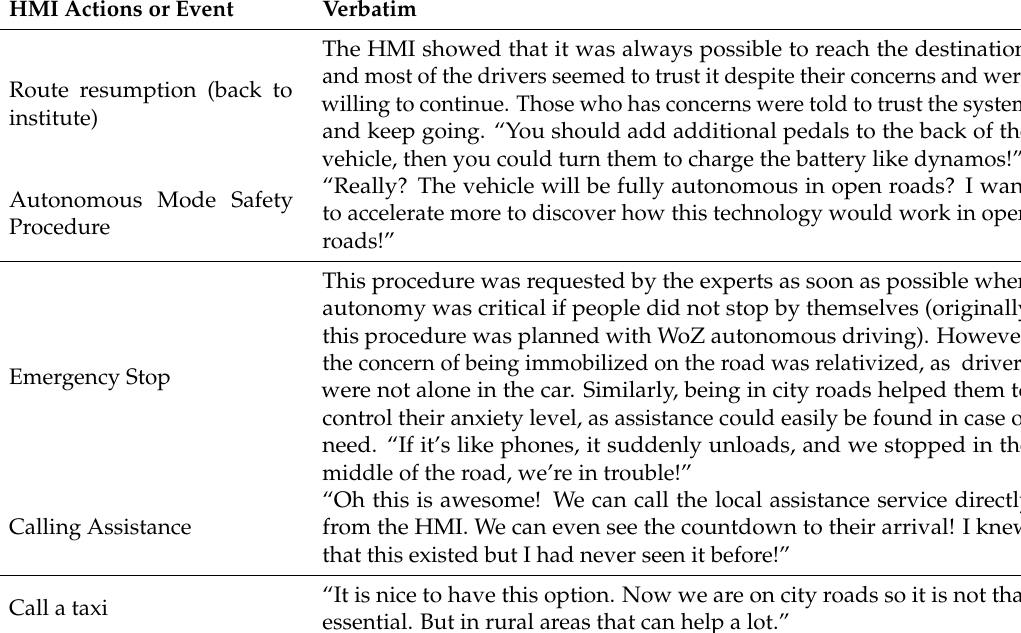
Table A3. Some verbatims pronounced during Scenario